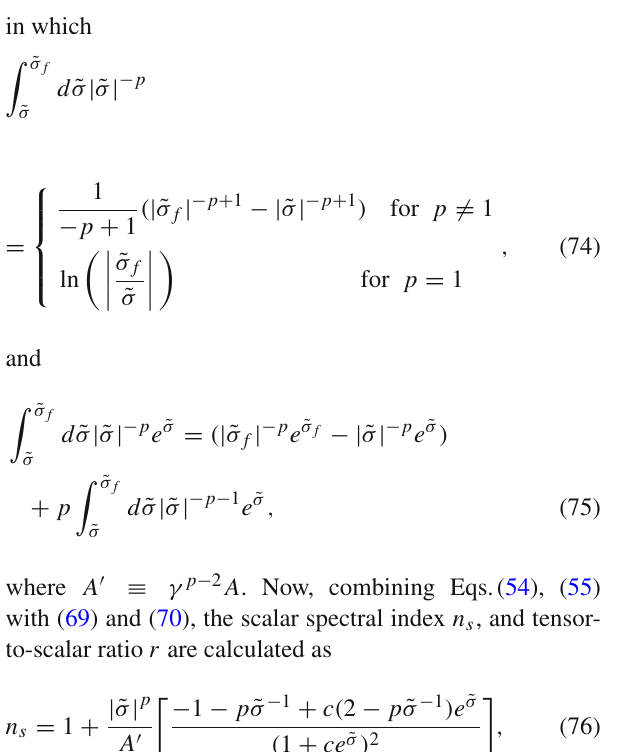
confidence regions. Depending on the values of p and c , the curves of r ( n s ) lie within the 68 or 95% confidence regions of the Planck 2018 TT, TE, EE + lowE + lensing data, in such a way that c = 0 is obviously more consistent with observational data than c = 10. More details on the